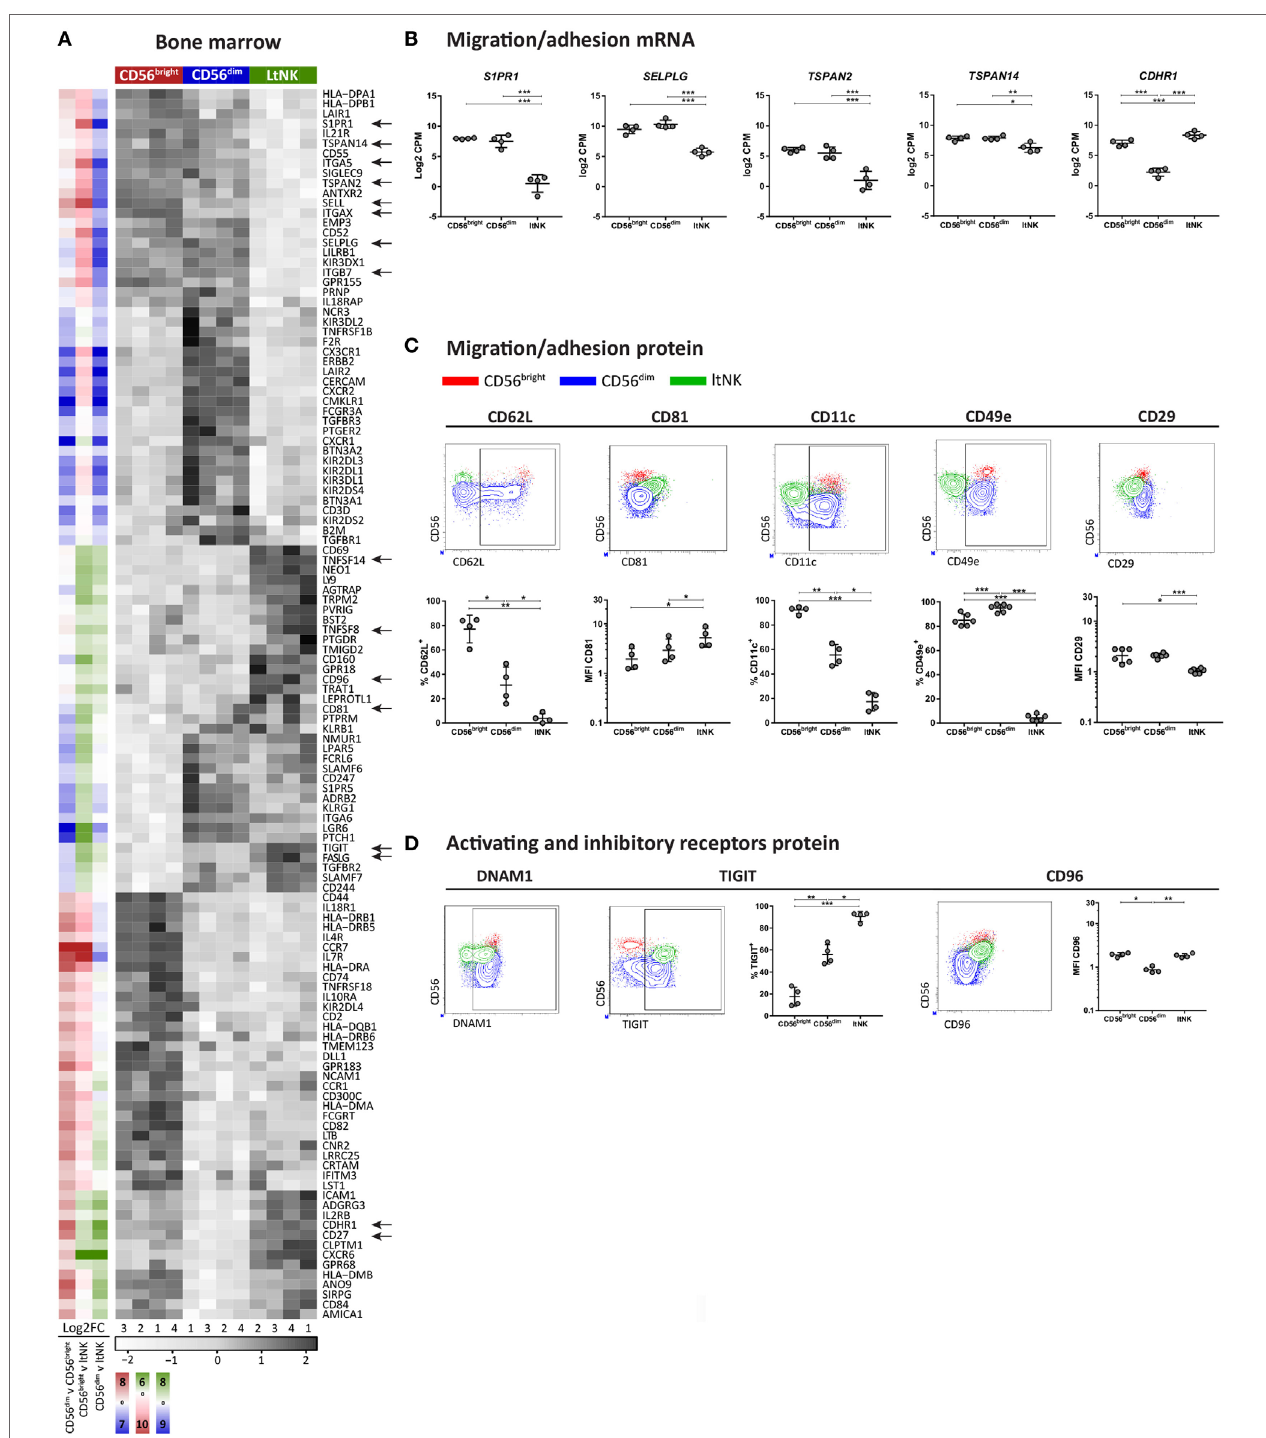
FigUre 3 | Surface molecule profile of ltNK cells reveals altered adhesion molecule repertoire. (a) Heatmap shows scaled mRNA expression values of genes, which encode surface molecules and have the highest or lowest mRNA expression [false discovery rate (FDR) < 0.05] in 1 of the 3 bone marrow (BM)-derived natural killer (NK) cell subsets. The column side bars represent the log2-fold change (FC) of gene expression levels in one NK cell subset versus another. The color indicates in which NK cell population the gene is expressed at the highest level (green = ltNK, red = CD56 bright , blue = CD56 dim ). The color intensity represents the magnitude of the FC. (B) Normalized mRNA expression levels of differentially expressed surface molecules involved in migration/adhesion. *FDR < 0.05, **FDR < 0.01, ***FDR < 0.001. CPM, counts per million of uniquely mapped reads; FDR, false discovery rate. (c,D) Validation of mRNA expression of surface molecules by flow cytometry. Shown are representative dot plots of BM-derived NK cells. MFI, mean fluorescence intensity. * P < 0.05, ** P < 0.01, *** P < 0.001, by one-way ANOVA. Mean ± SD are shown in (B–D)